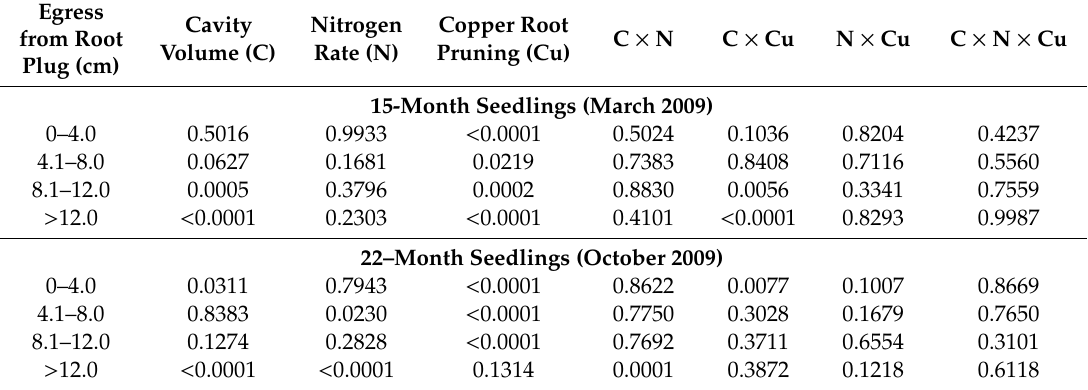
Table 8. p- values for the e ff ects of nursery treatments (cavity volume, N rate, and Cu root pruning) and their two- and three-way interactions on percent egress of the first-order lateral roots from each of four root plug zones in seedlings excavated 15 and 22 months after outplanting using analysis of